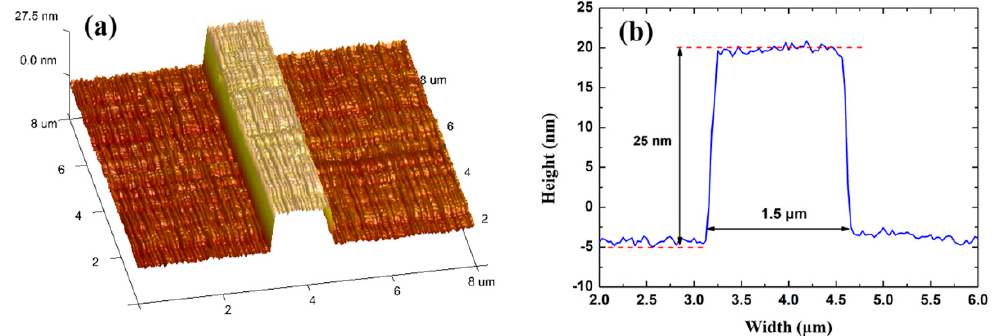
Figure 10. ( a ) areal scan, and ( b ) linear scan of an Au stripe on the SU-8 bottom cladding by atomic force microscopy. The Au stripe is 1.5 μ m wide and 25 nm high.